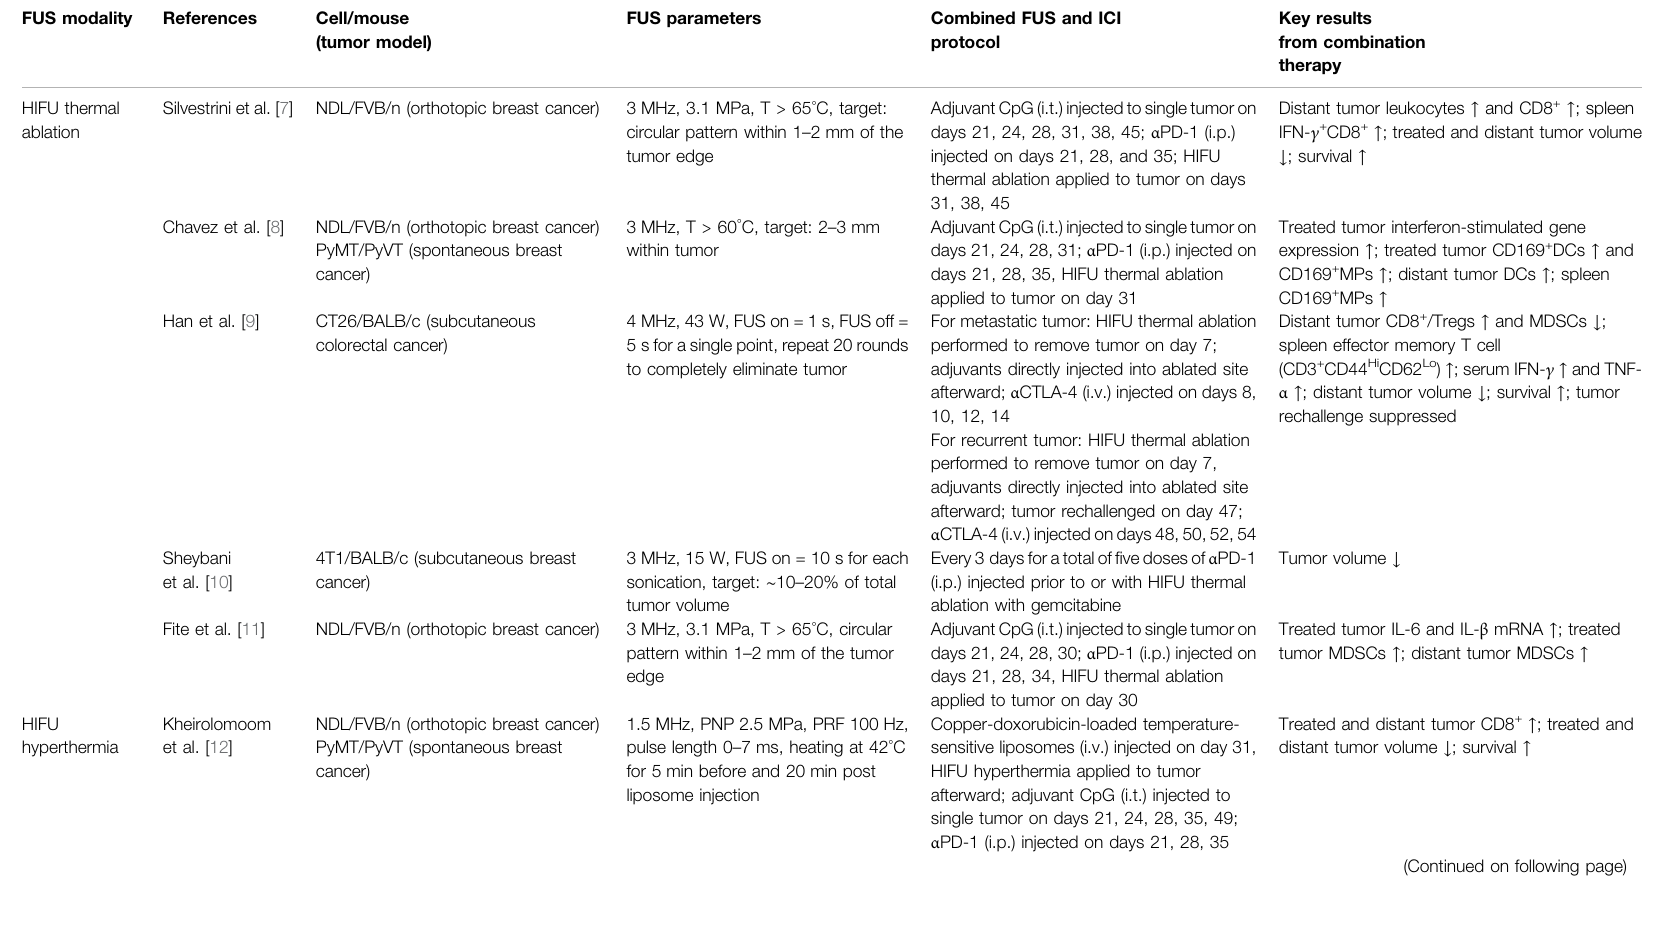
TABLE 2 | Summary of therapeutic ultrasound-enhanced ICI